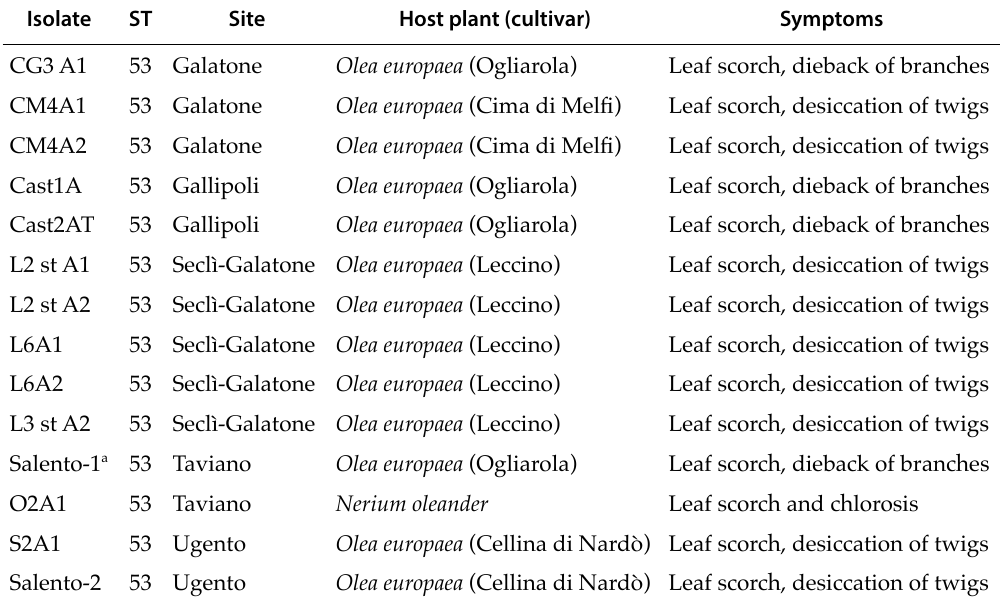
Table 1. Geographic and host origins, and disease symptoms, for Xylella fastidiosa isolates used in this study. Isolate MLST- derived sequence type (ST) is included. All sites are localities in Apulia region of Italy.